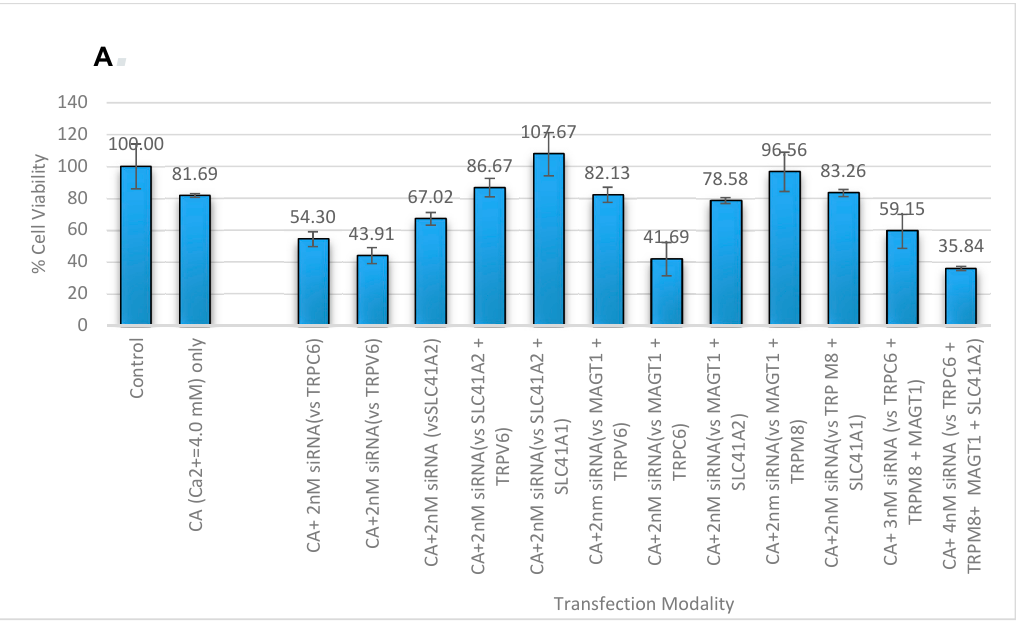
Figure 9. CA-multiple siRNAs to determine synergistic cytotoxicity: ( A ) MCF-7 cells; ( B ) 4T1 cells. Cell viability assessment in breast cancer cells for the NP-siRNA formed with a fixed concentration of exogenous CaCl 2 . Cells were treated with media (untreated), NPs formed with 3 mM (for 4T1) and 4 mM (for MCF-7) of exogenous CaCl 2 , and different combinations of NP-siRNA formed with 1 nM of individual siRNA. After 44 h of treatment, cell viability was measured by MTT assay. Values are represented as the mean % of cell viability ± SEM, when compared to untreated cells, where N = 3. We infer that this is probably because there are more than one type of calcium or magnesium channels for the cells, thus the knockdown of a group of these proteins is necessary to produce a robust effect. As the greatest synergistic effect was seen when a magnesium transporter (MAGT1)